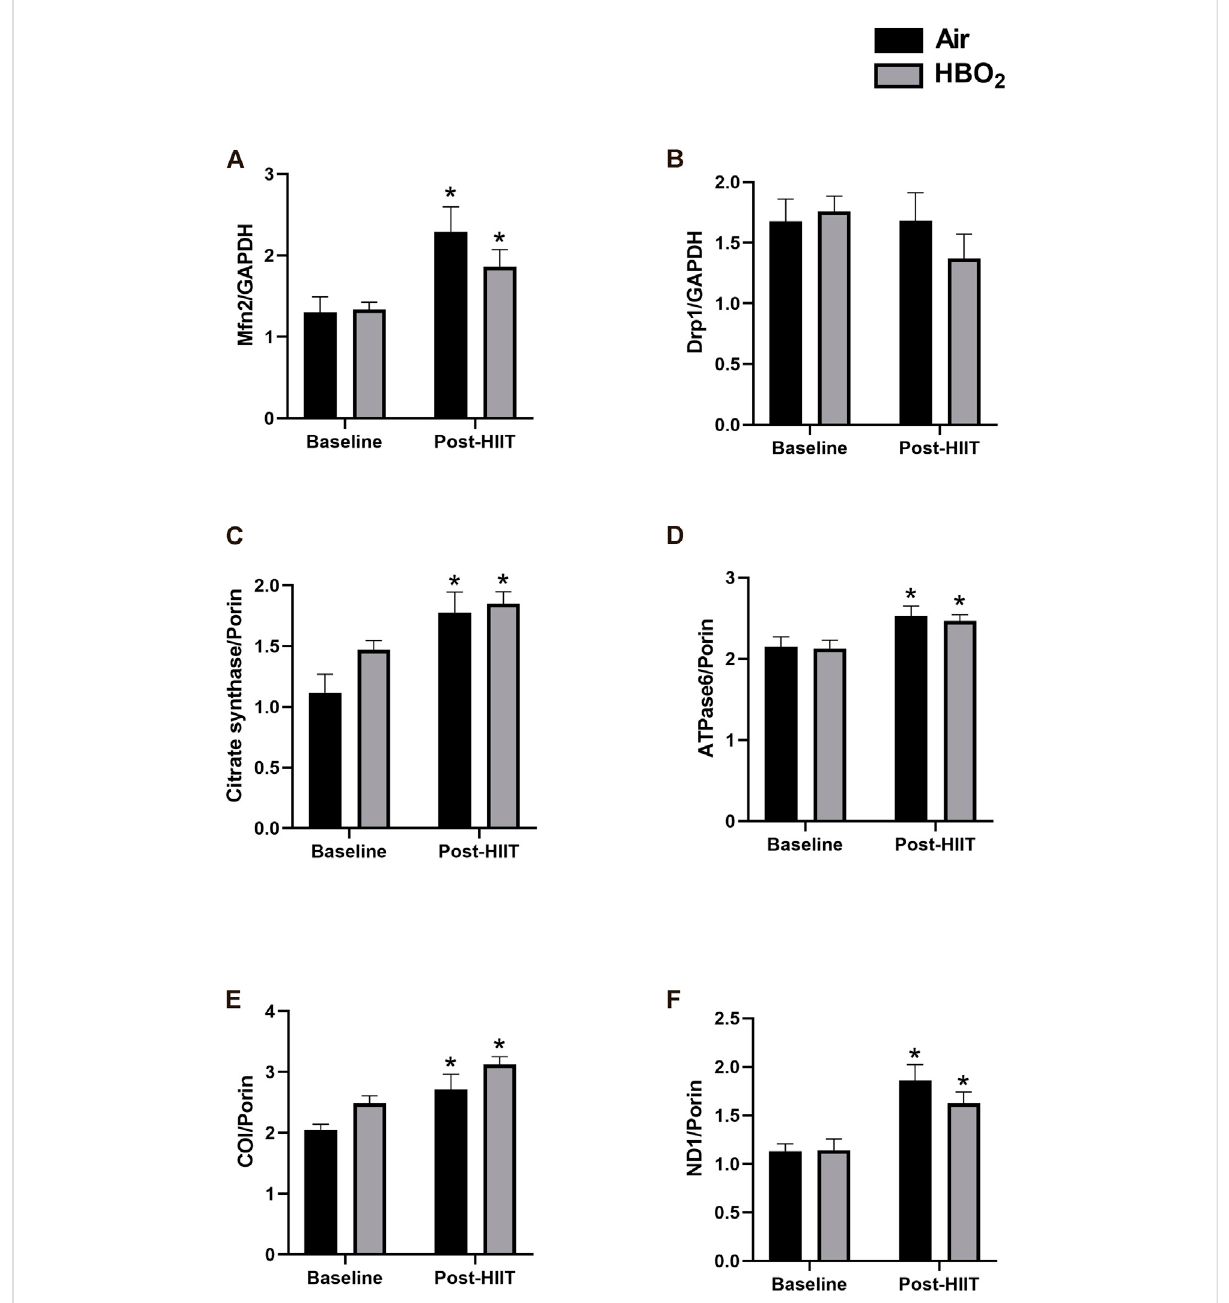
FIGURE 3 Mitochondrialproteinexpression.Expressionofthefollowingskeletalmuscleproteinswasmeasuredbywesternblot: (A) Mfn2,mitofusin-2; (B) Drp1,dynamin-1-like protein; (C) Citratesynthase; (D) ATPase6,mitochondrialATP synthasesubunita; (E) COI,cytochromecoxidase subunit1;and (F) ND1, NADH-ubiquinone oxidoreductase chain 1. Reference proteins were either GAPDH or Porin. Statistical analysis was 2-way ANOVA with repeatedmeasuresandFisher ’ sLSDpost-hoctest.* p < 0.05showssigni fi cantwithingroupcomparison(i.e.baselinevs.post-HITT).Groups:air, black bars; HBO 2 , grey